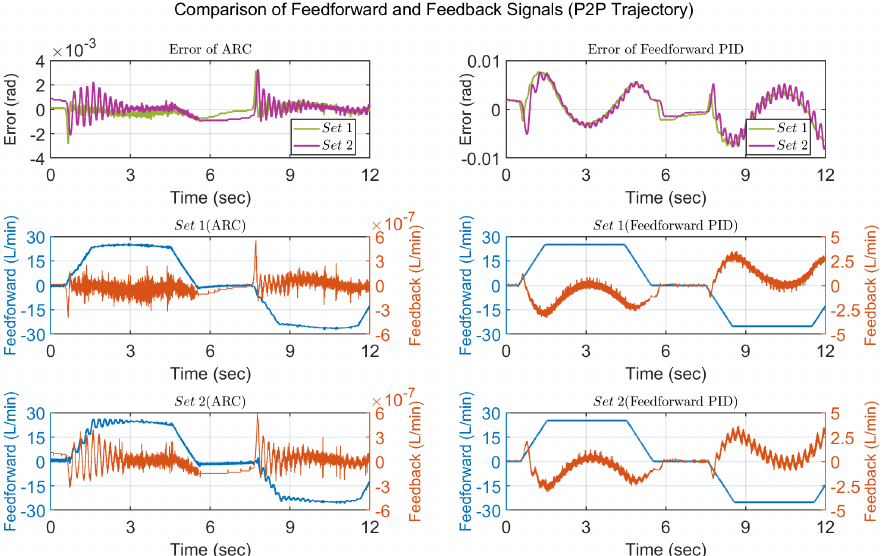
Figure 11. The comparison of feedforward and feedback between ARC and feedforward PID in the P2P trajectory.